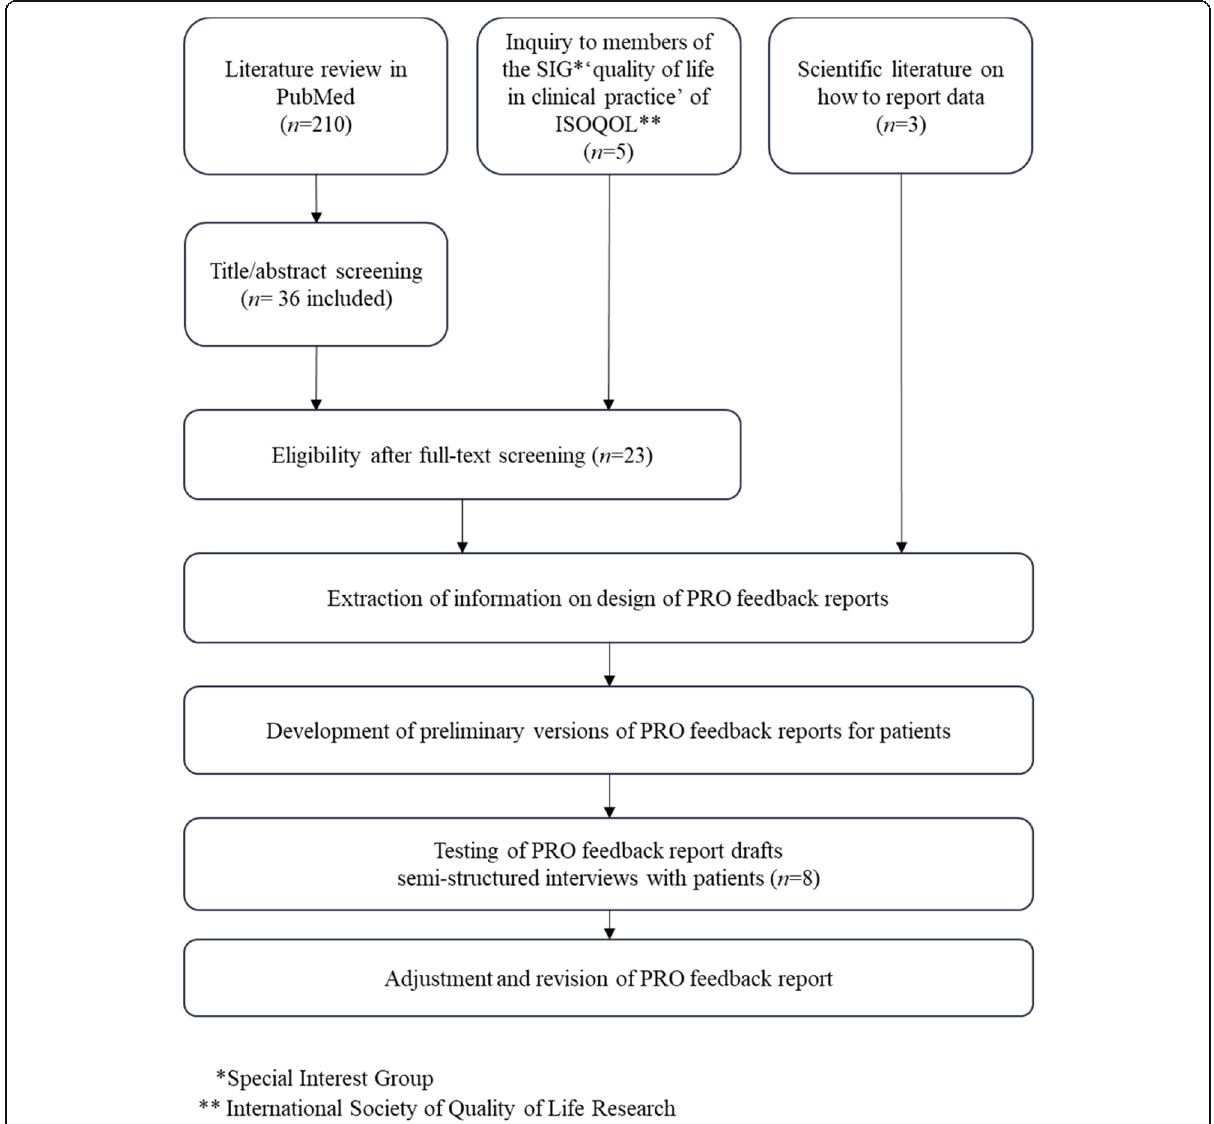
Fig. 1 PRO feedback report development process – flow